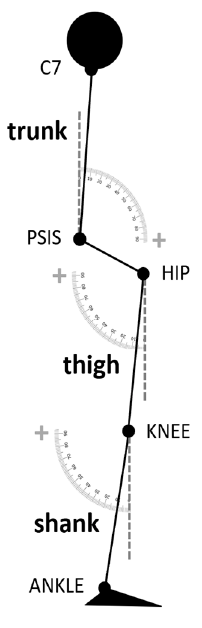
Figure 1. Scheme of the postural angles analyzed in the study. The trunk angle was defined as the inclination of the line passing through the markers placed on the middle point between the two posterior superior iliac spines and the seventh cervical vertebra with respect to the vertical axis of the laboratory. The thigh angle was calculated as the angle between the vector connecting the knee and hip center of rotation and the vertical axis of the laboratory. The shank angle was computed between the line connecting the joint centers of the knee and ankle and the vertical axis of the labor- atory.